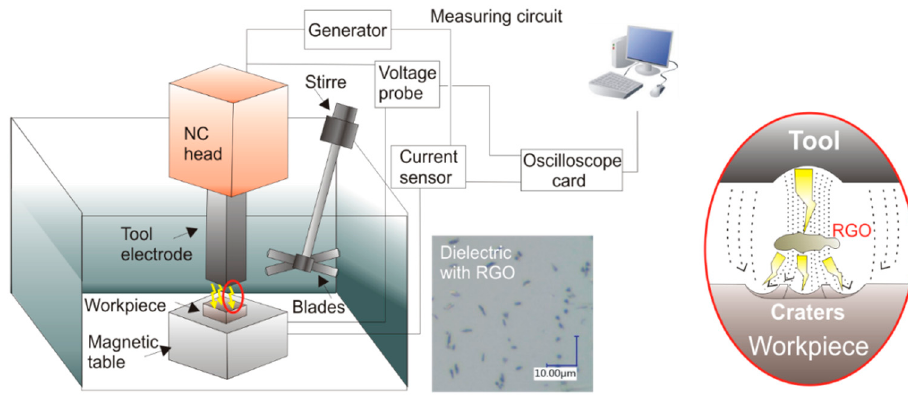
Figure 1. Schematic illustration of experimental setup.